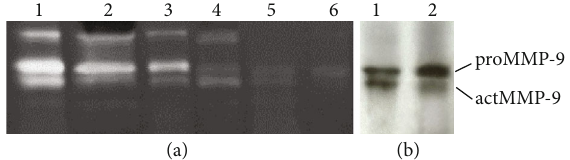
Figure 1: Gelatin zymography analysis of meningitis cerebrospinal fl uid (CSF). (a) Lanes 1-3 represent CSF with elevated levels of MMP-9, and lanes 4-6 represent CSF with low levels of MMP-9. (b) Lanes 1 and 2 represent western immunoblot analysis of MMP-9. Mobilities of 92kDa pro MMP-9 (proMMP-9) and active MMP-9 (actMMP-9) species are indicated on the